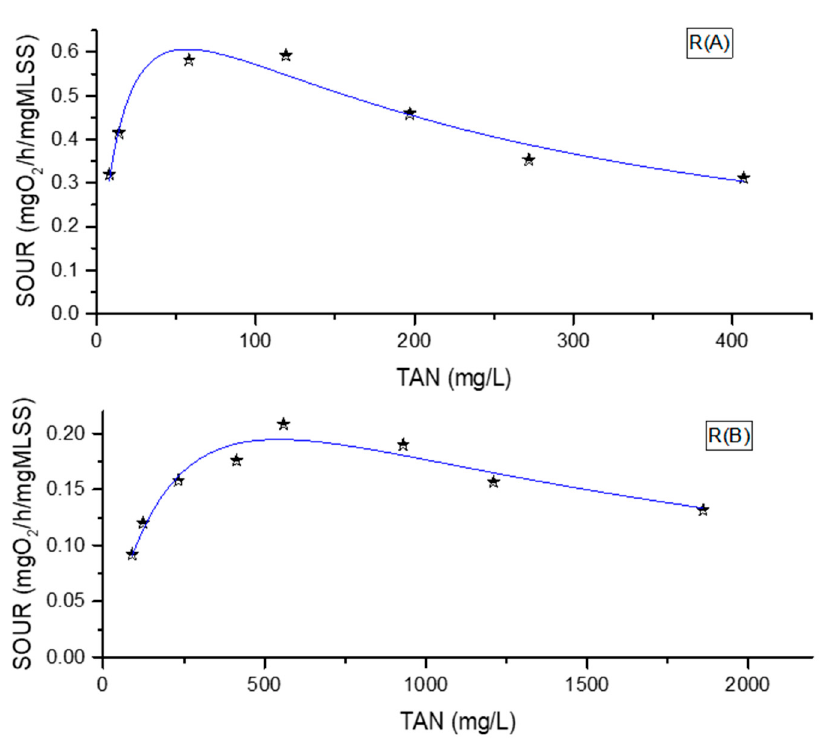
Figure 3. R(A)-1 and R(B)-1 inhibition model [7] was fitted in the batch experiment and R(A) and R(B).